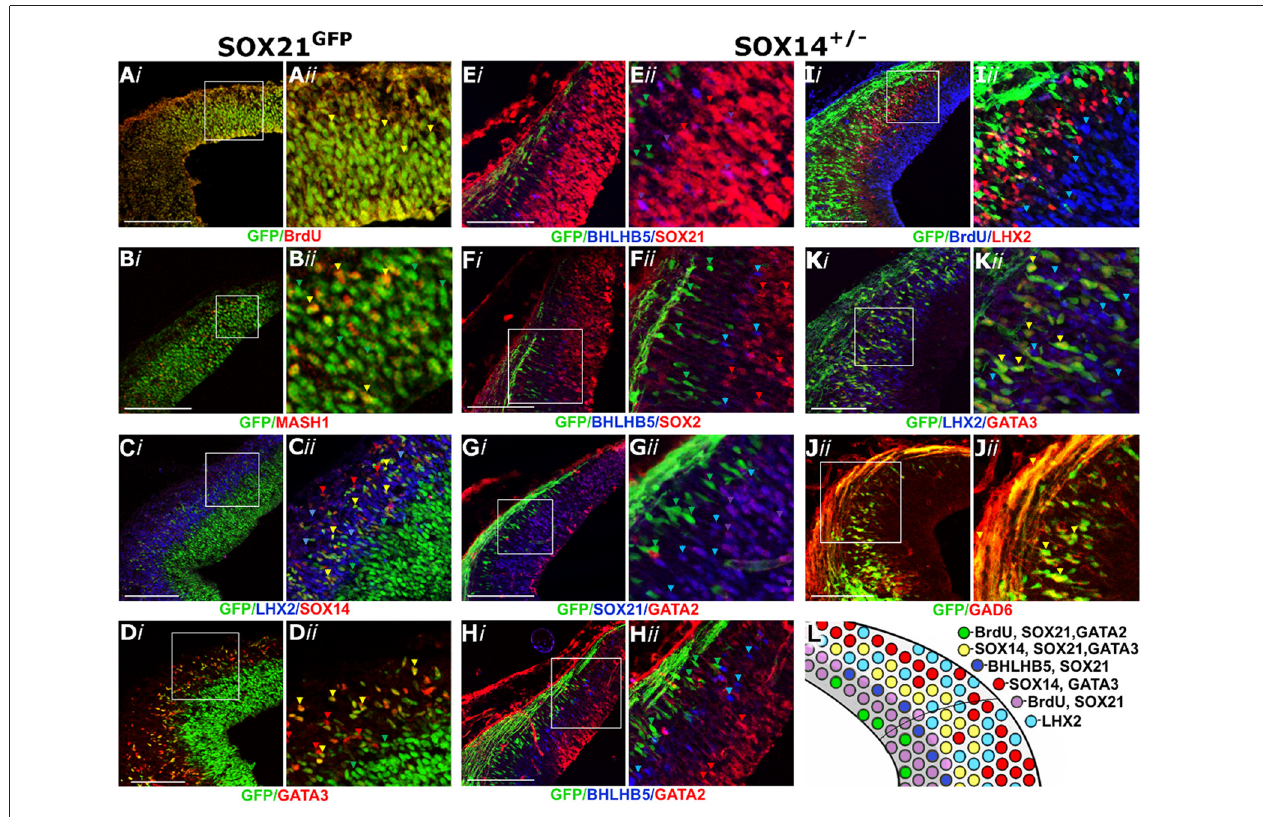
FIGURE 2 | Characterization of the SOXB2 expression in the developing dorsal midbrain at E12.5. Coronal sections of SOX21 GFPn midbrains stained with BrdU (A) , MASH1 (B) , LHX2 and SOX14 (C) and GATA3 (D) antibodies. Coronal sections of SOX14 + / − midbrains were stained with BHLHB5 and SOX21 (E) , BHLHB5 and SOX2 (F) , SOX21 and GATA2 (G) , BHLHB5 and GATA2 (H) , BrdU and LHX2 (I) , GATA3 and LHX2 (K) and GAD6 (J) antibodies. The results of this analysis are summarized in the schematic (L) . Red, green and blue arrows indicate the corresponding single stained cells (as shown in the label) and yellow and purple arrows denote co-localization between green and red cells and blue and red, respectively. Scale bar, 150 µ